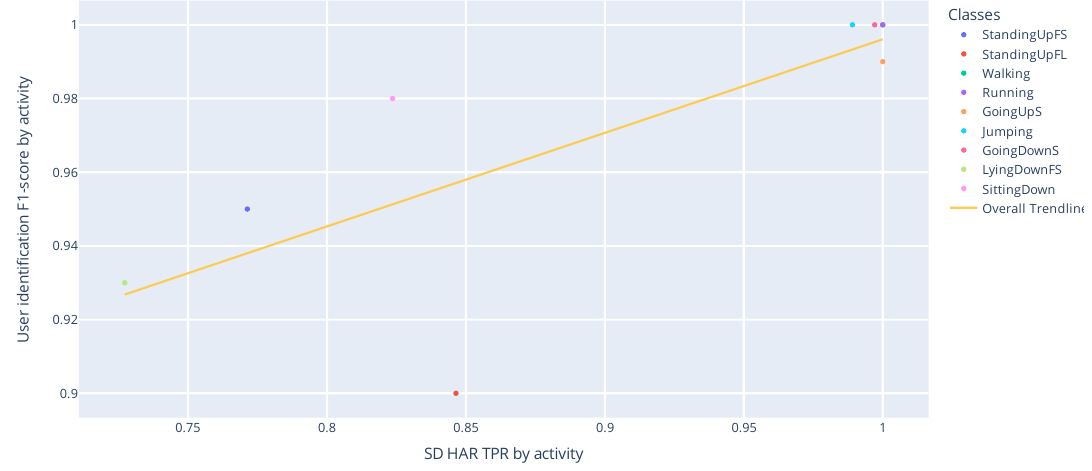
Figure 10. Comparison between the best performances obtained with HAR with SD, biometric user identification, and HAR with SI.